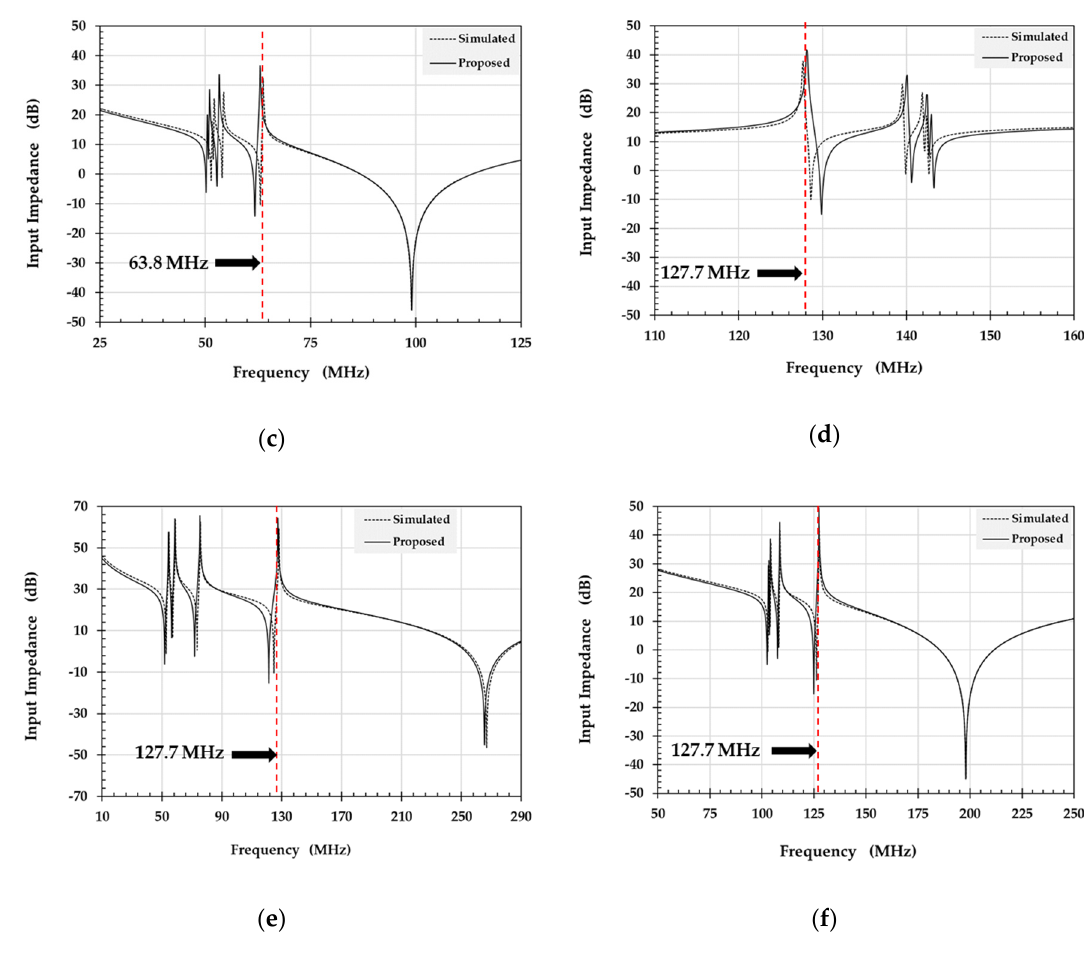
Figure 8. Input impedance obtained using proposed analytical solution and conventional 2D simulation for the different configurations of the birdcage RF coil: ( a ) 1.5T low pass, ( b ) 1.5 T high pass, ( c ) 1.5 T band pass, ( d ) 3 T low pass, ( e ) 3 T high pass, ( f ) 3 T band pass.